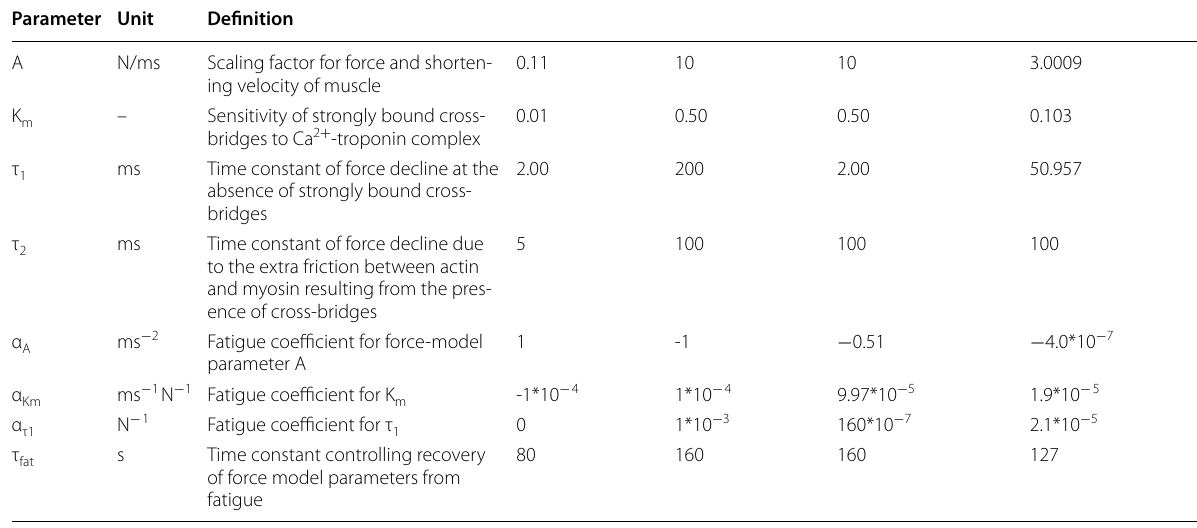
Table 2 Parameter units, definitions, and values for force fatigue model (Ding et al. 2003). Parameter range values were defined by values used in the referenced paper and an associated follow-up study for simulations of skeletal muscles (Doll et al. 2017). PSO- identified values were used for all simulations unless otherwise stated. Ding et al. 2003 values used in model perturbation simulations Free parameters for muscle activation model (Ding et al.